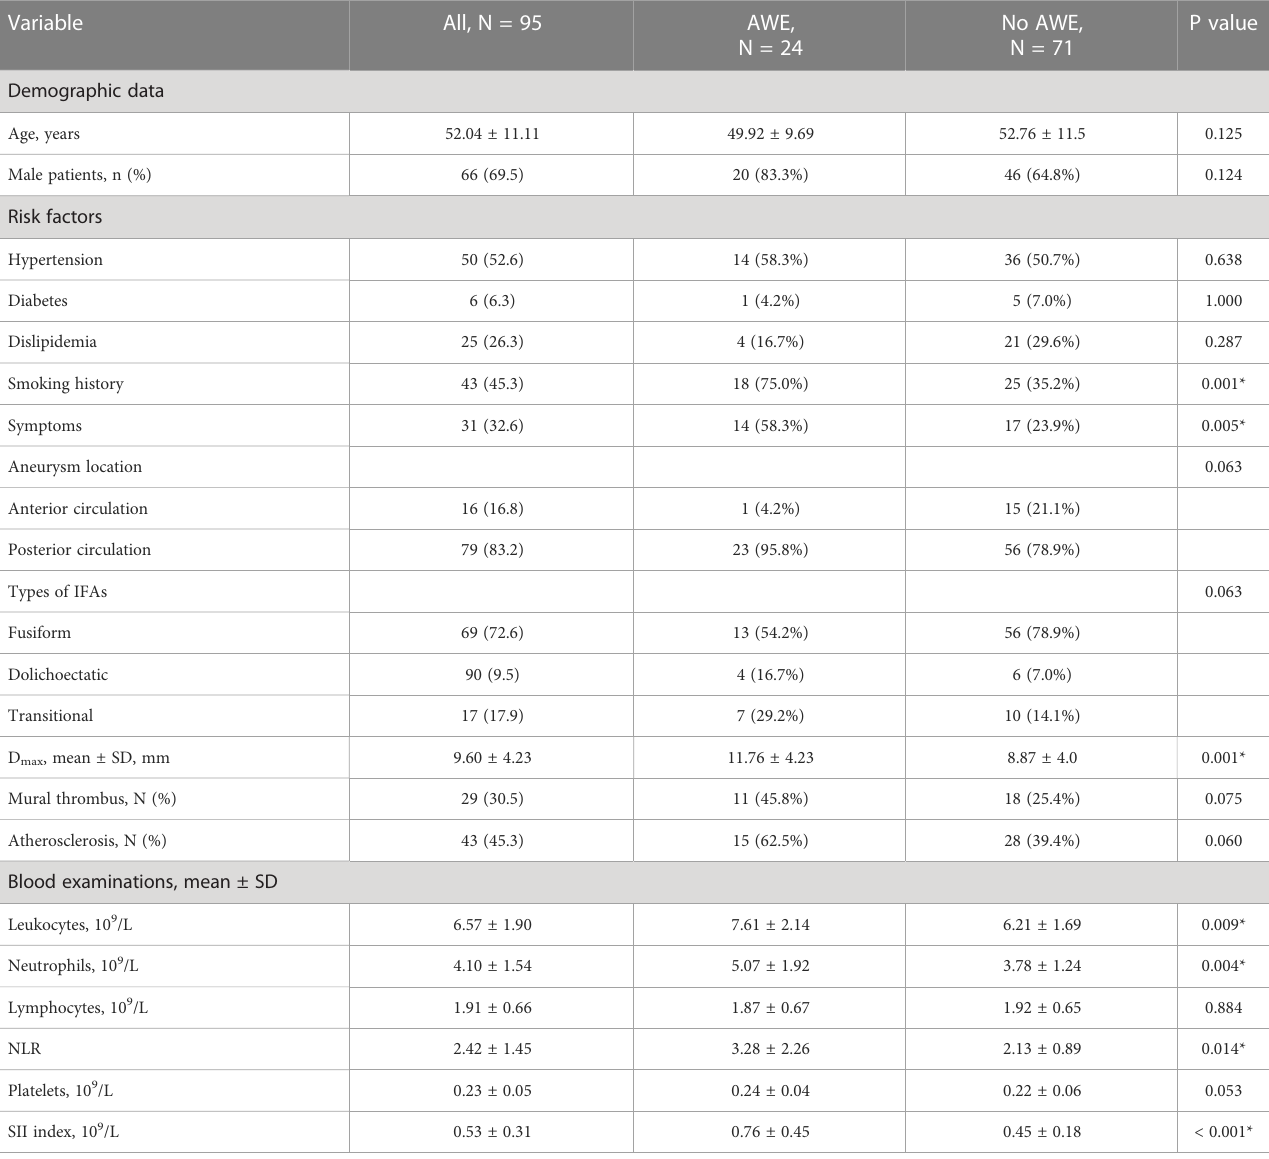
TABLE 1 Baseline characteristics of IFA patients with and without AWE.